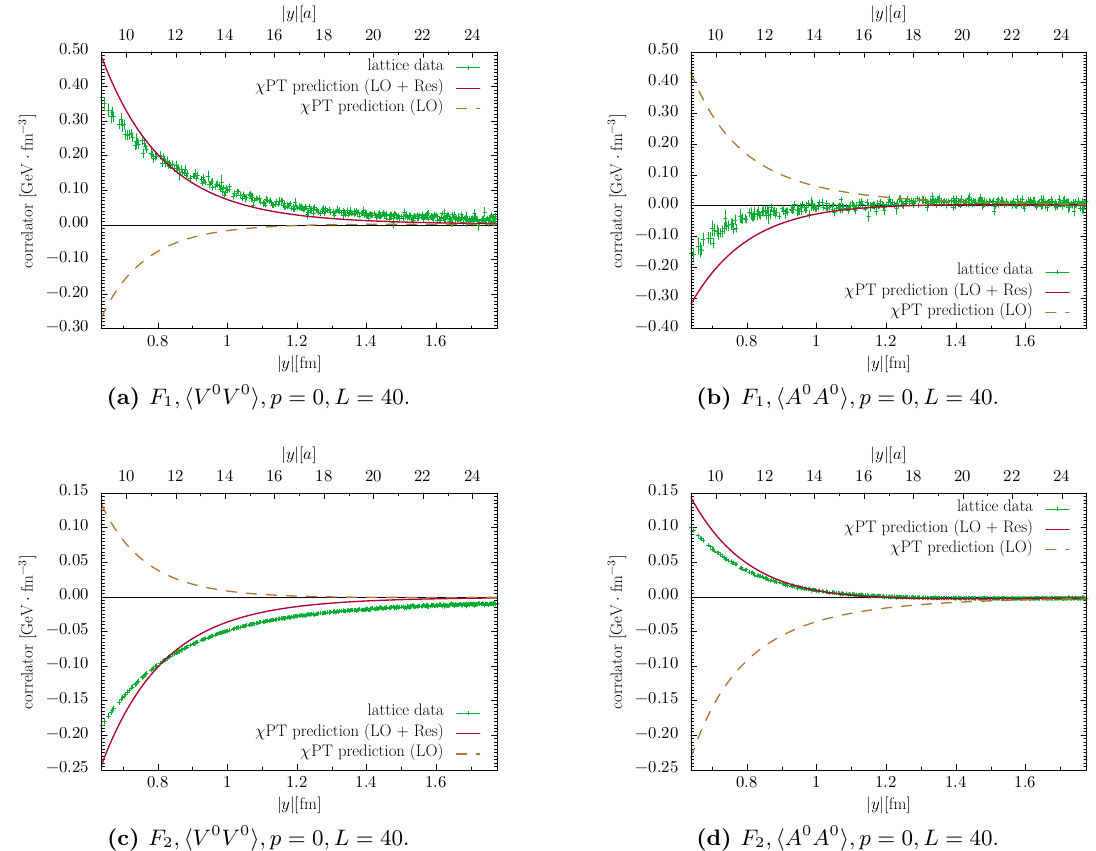
Figure 23. Comparison of our lattice results for theory. The results obtained from the leading-order chiral Lagrangian are denoted by \LO" and those including resonance exchange by \LO +